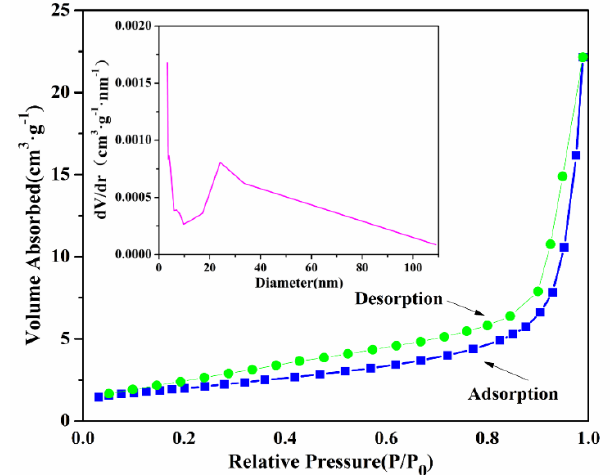
Figure 6. The N 2 adsorption – desorption isotherm of Bi 5 O 7 I/Mn x Zn 1 − x Fe 2 O 4 . The pore diameter distribution curve is shown in the inset image.